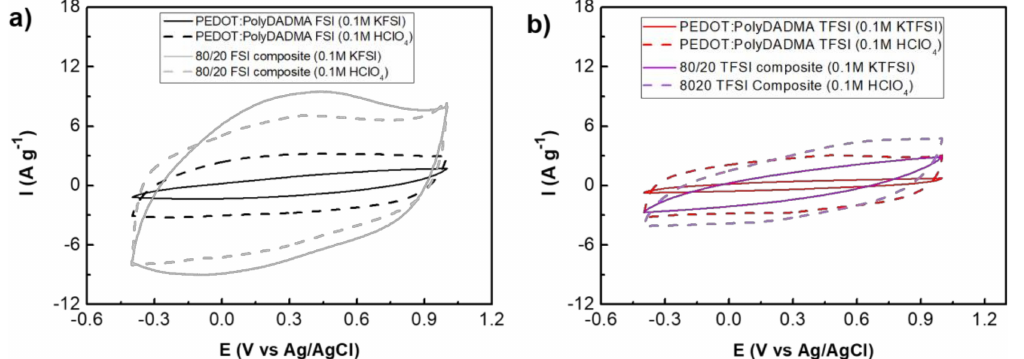
Figure 10. Voltammograms at 0.2 V s − 1 of ( a ) PEDOT:PolyDADMA FSI (black lines) and 80 / 20 PEDOT:PolyDADMA FSI / [C 2 mpyr][FSI] (grey lines) using 0.1 M KFSI (solid lines) and 0.1 M HClO 4 (dashed lines) and ( b ) PEDOT:PolyDADMA TFSI (red lines) and 80 / 20 PEDOT:PolyDADMA TFSI / [C 2 mpyr][TFSI] (purple lines) using 0.1 M KTFSI (solid lines) and 0.1 M HClO 4 (dashed lines). KFSI = Potassium